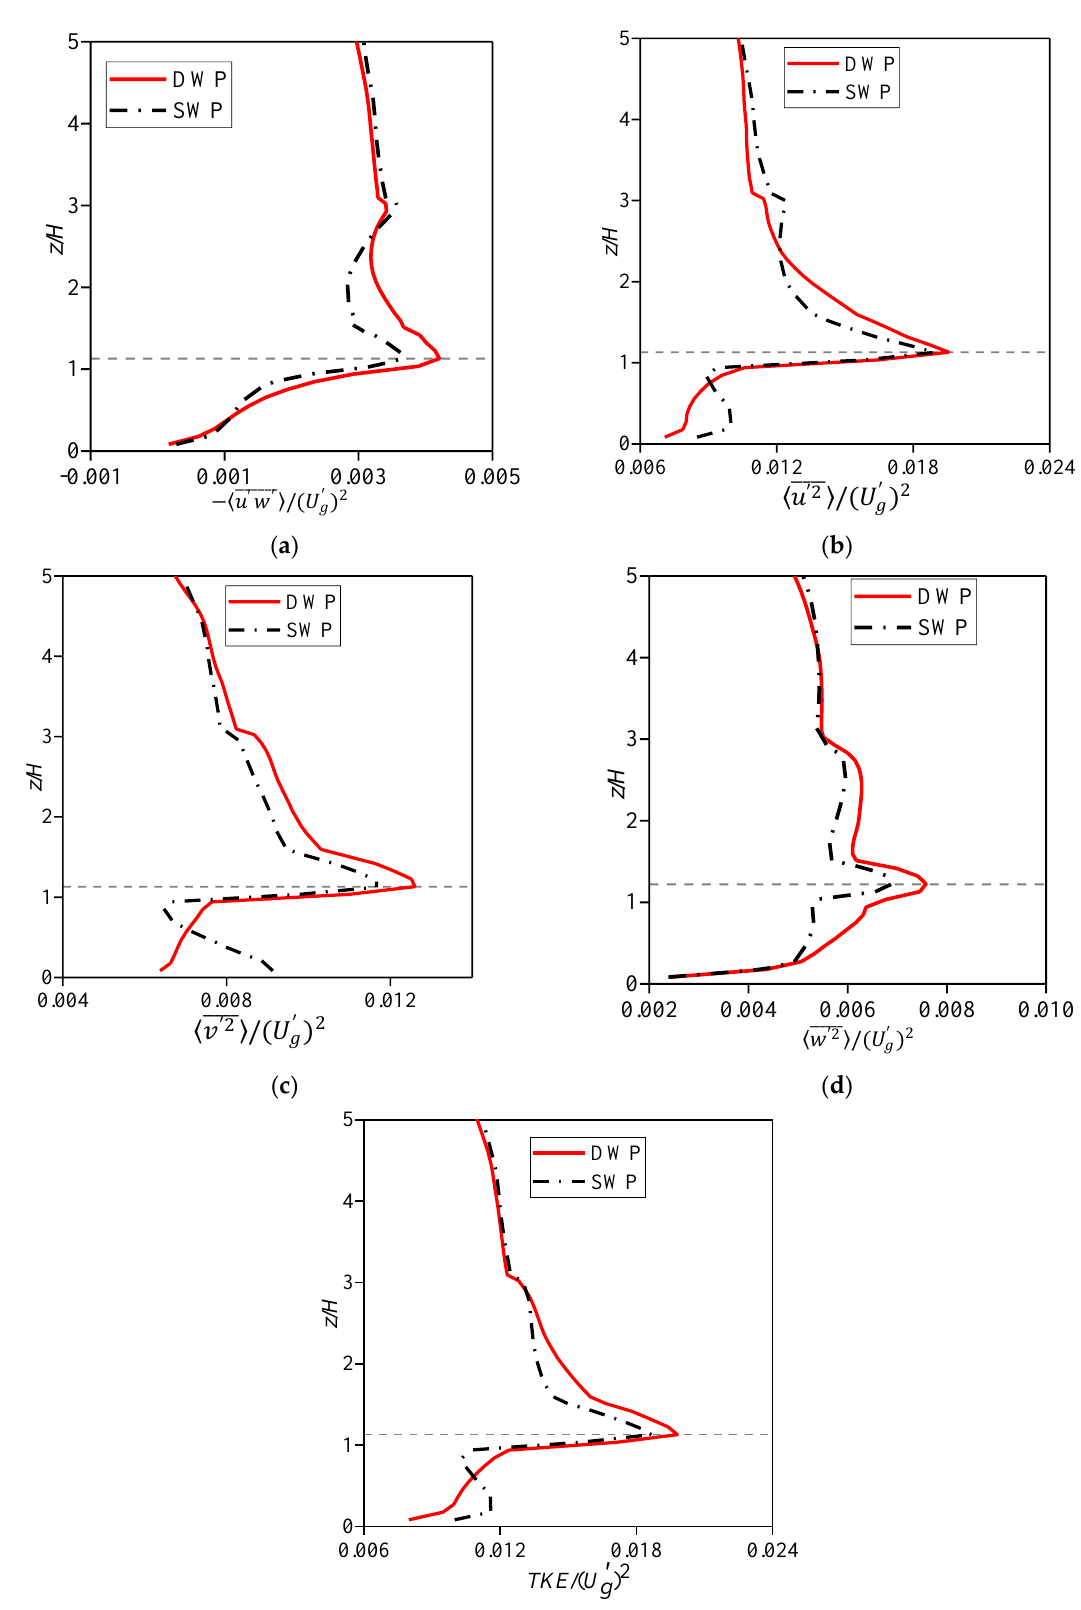
Figure 16. Reynolds stress components −〈𝑢 ′ 𝑤 ′ ̅̅̅̅̅̅〉 , 〈𝑢 ′2 ̅̅̅̅〉 , ⁡〈𝑣 ′2 ̅̅̅̅〉 , 〈𝑤 ′2 ̅̅̅̅̅〉 and TKE, normalized by ⁡(𝑈 𝑔′ ) 2 . Figure 16. Reynolds stress components ( a ) −(cid:104) u (cid:48) w (cid:48) (cid:105) , ( b ) (cid:104) u (cid:48) 2 (cid:105) , ( c ) (cid:104) v (cid:48) 2 (cid:105) , ( d ) (cid:104) w (cid:48) 2 (cid:105) and ( e ) TKE , normalized by ( U (cid:48) g ) 2